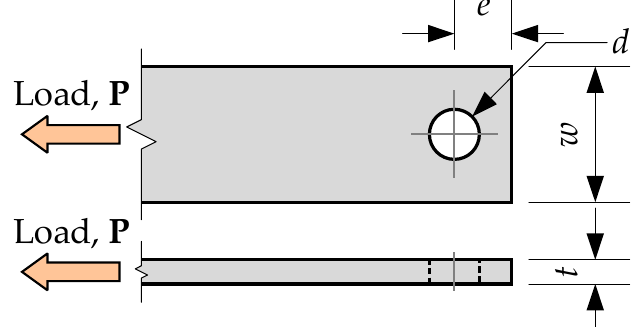
Figure 1. The connection geometry definition.